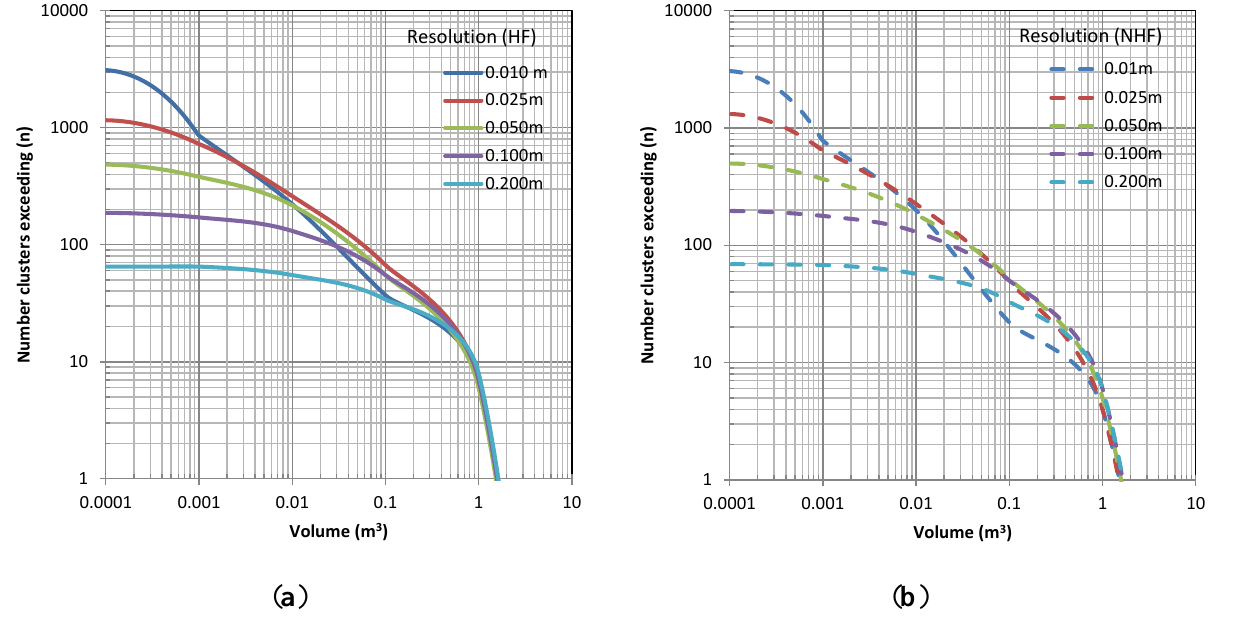
Figure 15. Comparison of magnitude–frequency curves (plotted based on exceedance) for various resolutions and with ( a , HF) and without ( b , NHF) hole filling for Site B between 2013 and 2014.